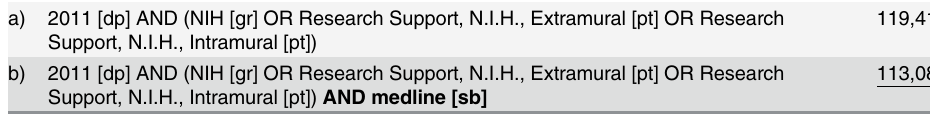
Table 1. PubMed searches identifying articles with funding support from the